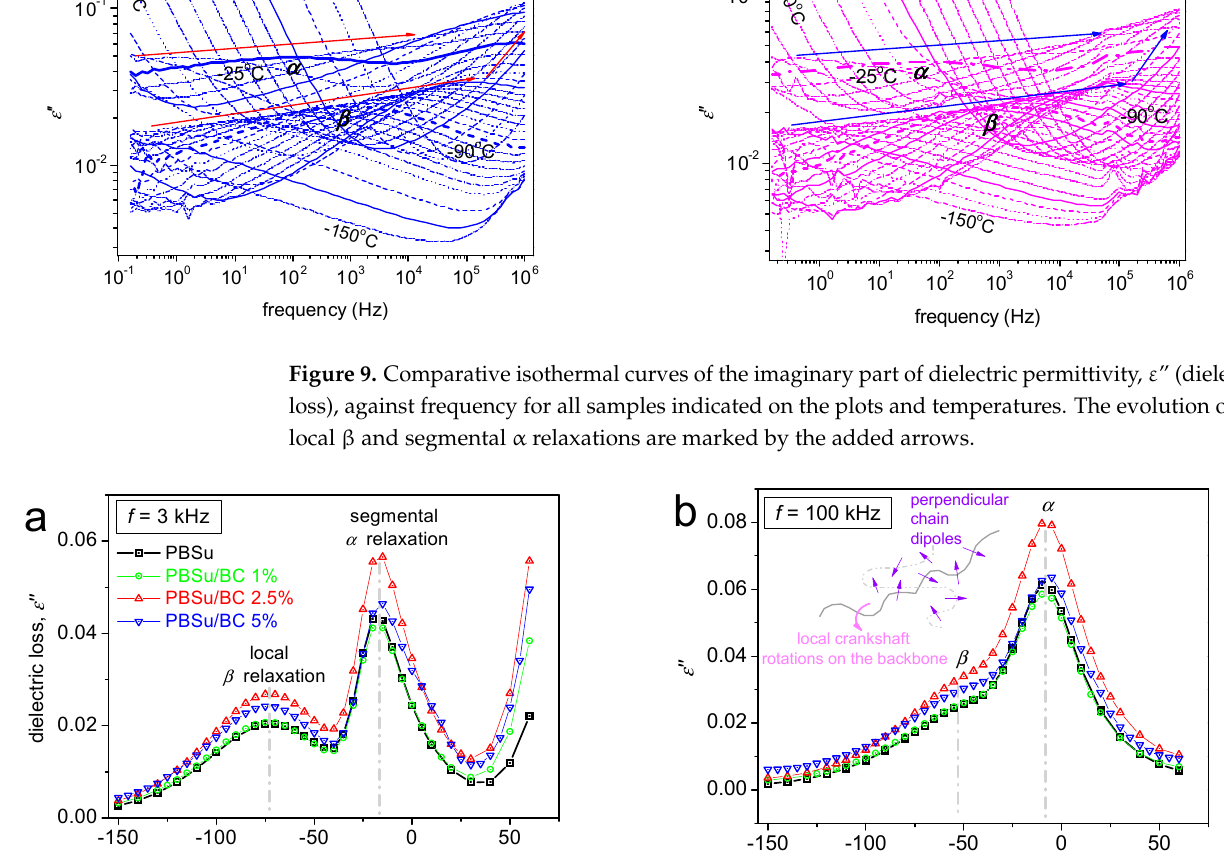
Figure 10. Comparative isochronal BDS curves, namely, the temperature dependence of the imagi- nary part of dielectric permittivity, ε ″ , for PBSu and the PBSu/BC biocomposites, for ( a ) f = 3kHz and ( b ) f =100 kHz. Indicated are the local and dielectric relaxation processes.